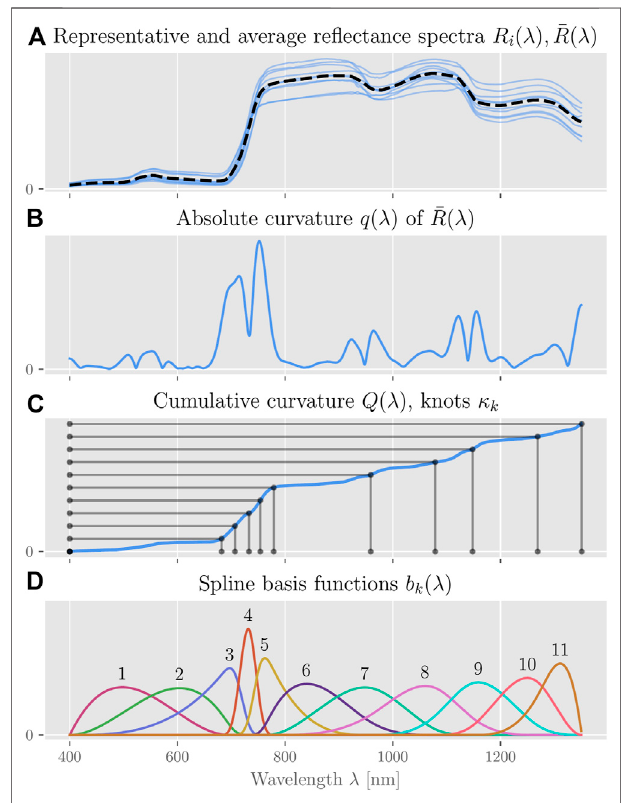
FIGURE1 | Adaptiveknot-placementforB-Splines. (A) Forthemeasured re fl ectance spectra R i ( λ ), (B) we calculate the mean absolute curvature q ( λ ). (C) We then fi nd knot positions such that the integral Q ( λ ) of this measure between any two successive knots κ i , κ i +1 is identical. (D) The result are 11 cubic spline basis functions b k ( λ ) with non-uniformly spaced knots.